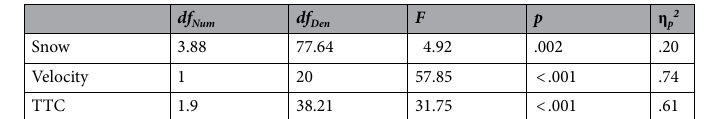
Table 3. Significant main and interaction effects of type 3 F -tests on mean constant errors. p -values and degrees of freedom in the table incorporate Huynh–Feldt correction if appropriate. df Num = numerator degrees of freedom. df Den = denominator degrees of freedom. η p2 = partial eta-squared.